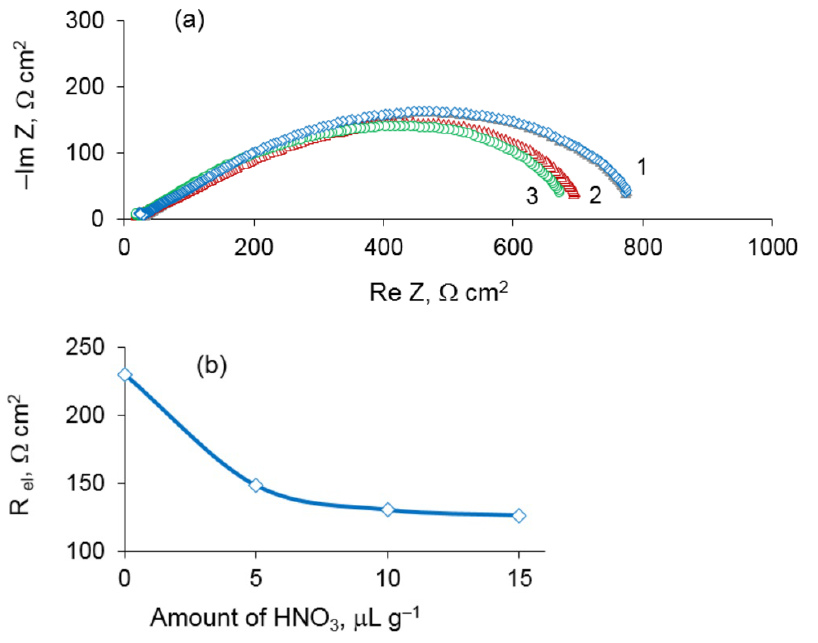
Figure 9. Impedance spectra of the cells Pt/YSZ/Pt with electrodes impregnated by 5 (1), 10 (2) and 15 mL g − 1 HNO 3 at 600 ◦ C ( a ) and electrode polarization resistance of Pt/YSZ/Pt cell vs. amount of HNO 3 ( b